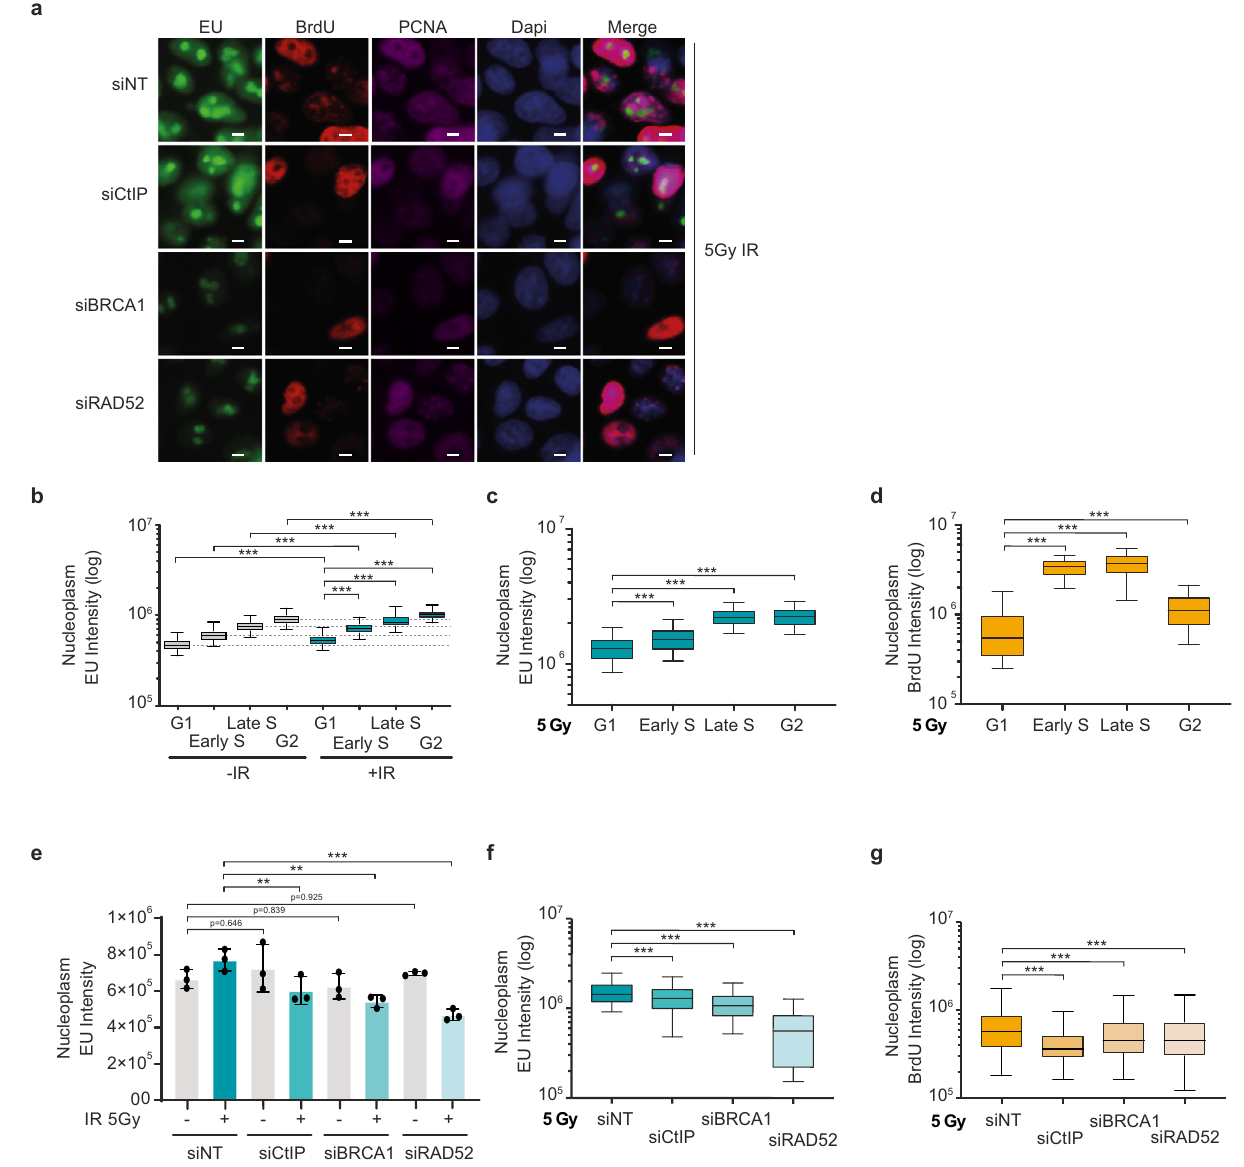
Fig. 1 | DNA resection (ssDNA) correlates with nascent RNA synthesis. a Representativeimmuno fl uorescenceimagesofEU,BrdU,PCNAandDAPIstaining in U2OS cells depleted for the indicated DDR factors, irradiated with 5Gy and stainedupon30-minutelabelingwithEUandBrdUthatstartedimmediatelyafterIR exposure. Scale bar: 10 μ m. b Graph shows nucleoplasm (non-nucleolar) EU intensity in different cell cycle phases in non- and irradiated-U2OS cells. EU com- ponent was added upon DNA damage using 5Gy in irradiated cells and labeled for 30mininbothcellularconditions. c GraphshowsEUintensityindifferentcellcycle phases in control U2OS cells irradiated and labeled for 30min as in ( a ). d Graph shows intensity of BrdU staining under non-denaturing conditions to visualize stretches of ssDNA, as a DNA resection marker in cell cycle phases of U2OS cells irradiated (5Gy). e Bar graph represents nucleoplasm (non-nucleolar) EU intensity in cells treated by siRNAs against indicated genes in non- and irradiated cells. EU component was added upon DNA damage using 5Gy in irradiated U2OS cells and